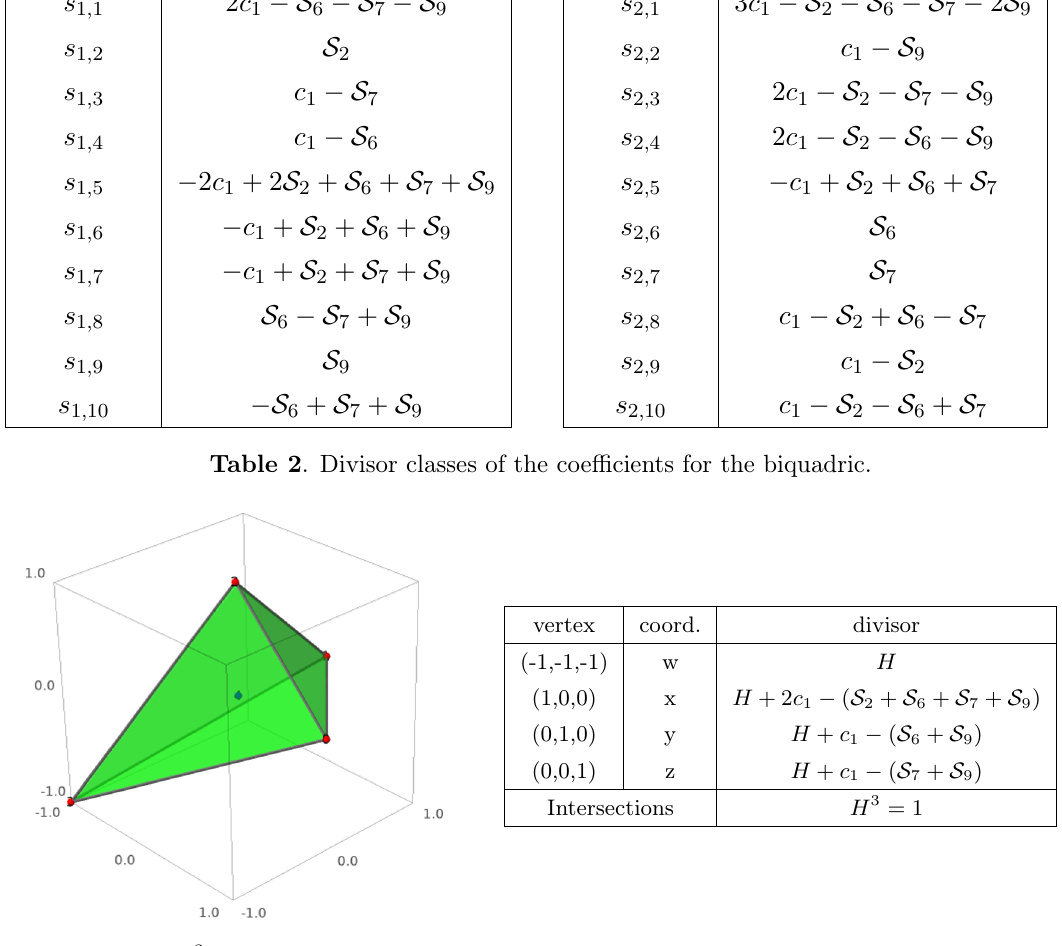
Figure 2 . The P 3 ambient space polytope of nef (0,0) is depicted on the left. The table shows the respective coordinates and the bundles they transform